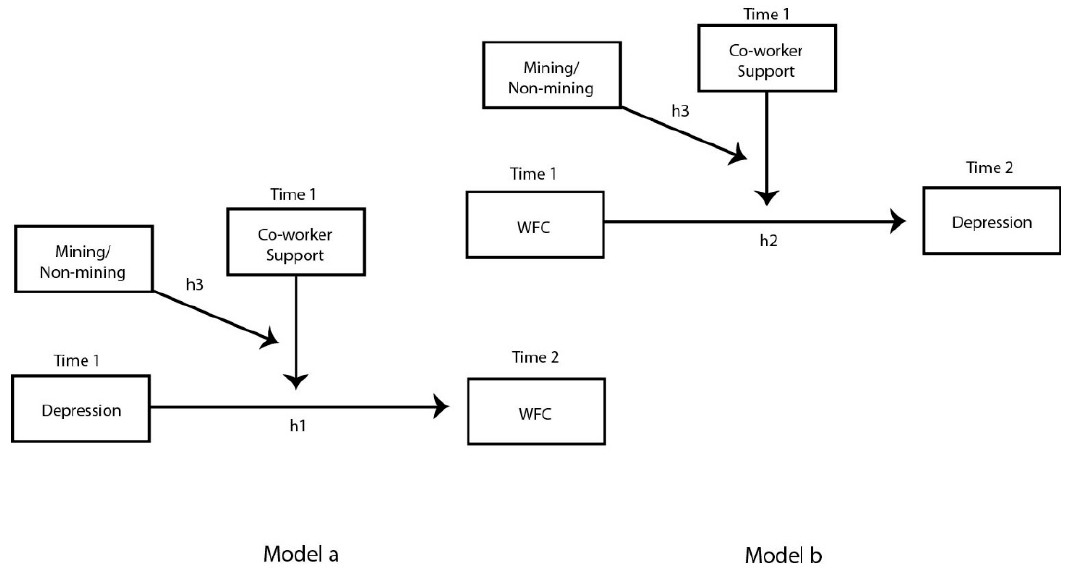
Figure 1. Buffering hypothesis of a Work-Family Conflict/Depression loss spiral. WFC = Work-Family Conflict; h1-3 indicate hypotheses tested.